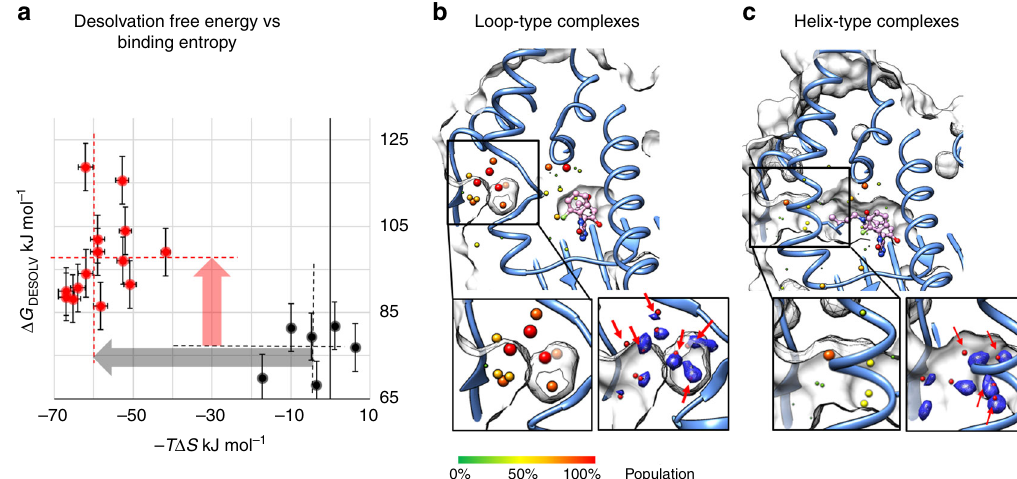
Fig. 4 Simulation of the protein and ligand hydration effects. a Relation between the computed desolvation free energy of the inhibitors (see Methods section) and their measured binding entropy in ITC experiments. Compounds assigned as loop-binders are colored black and compounds assigned as helix-binders are colored red. Error bars show the root mean squared error of 3D-RISM predictions against experiment (RMSE = 5.4 kJ mol − 1 as reported in ref. 50 ). Black and red dashed lines indicate the average values of the desolvation energy and binding entropy for loop- and helix-binders, and the arrows show the corresponding differences between loop- and helix-binding compounds, as observed in experiment (gray) and in computations (light red). b , c Conserved water sites observed in loop-in ( b ) and helical ( c ) crystal structures (listed in Supplementary Table 5). The degree of conservation is visualized by increasing size and color; only water sites within 0.8 nm of N106 are shown. In the insets, water sites predicted by GIST 68 are depicted by blue mesh iso-surfaces at a water density value twice that of bulk water; the oxygen atoms of the crystallographic water sites are represented by red spheres; red arrows indicate the positions of stable water sites predicted by 3D-RISM simulations 66 (for details, see Supplementary